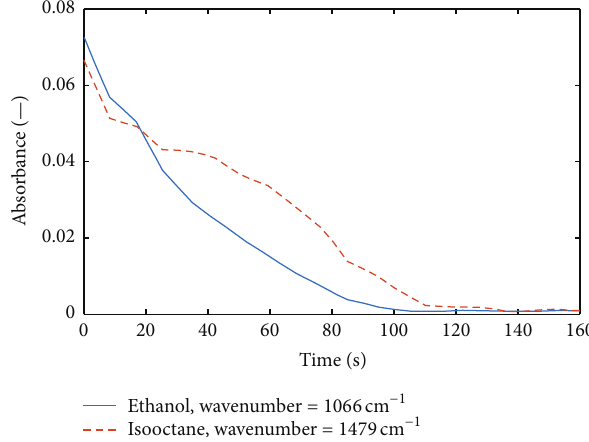
Figure 7: Binary droplet (85% isooctane and 15% ethanol by vol- ume) evaporation measured by IR